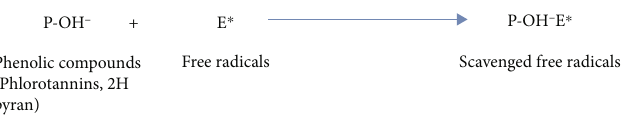
Figure 4: Antioxidant activity mechanism of algal metabolites.